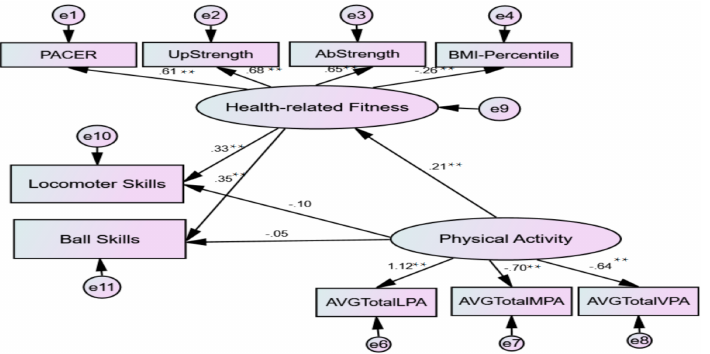
Figure 2. The Structural Model with Standardized Path Coefficients for Model-2: PA»HRF»FMS. PACER = Progressive Aerobic Cardiovascular Endurance Run; PA = physical activity; BMI = body mass index. * p < 0.05; ** p <